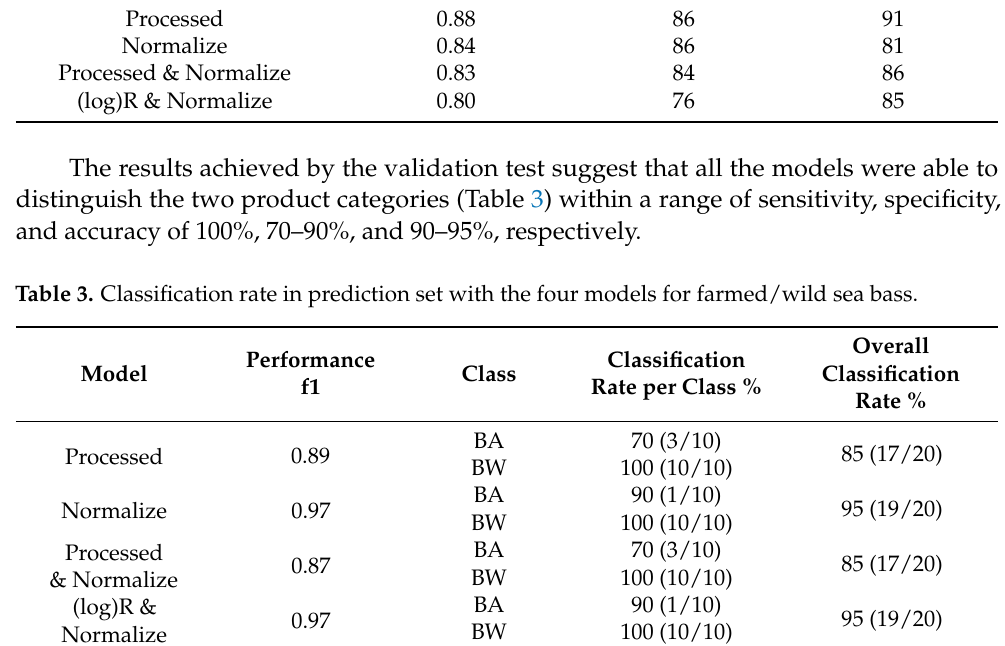
Table 2. Classification results: farmed/wild sea bass. All values are expressed in percentage. Predicted BA Predicted BW Model Performance f1 (%) (%) Processed 0.88 86 91 Normalize 0.84 86 81 Processed & Normalize 0.83 84 86 (log)R & Normalize 0.80 76 85